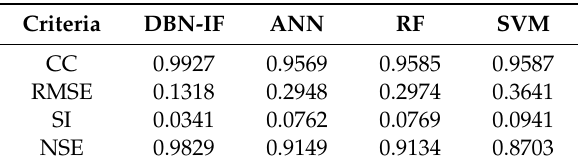
Table 8. The CC, root mean square error (RMSE), scatter index (SI), Nash–Sutcli ff e (NSE) of WVHT predictions with lead time = 1 h.